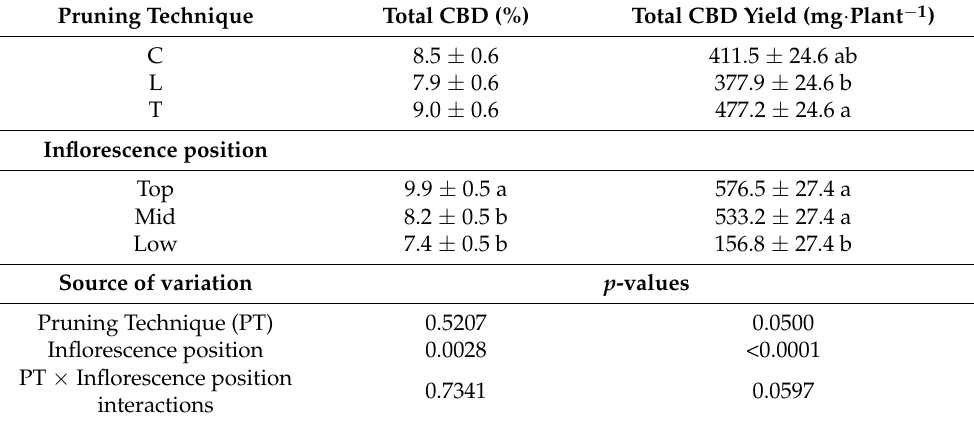
Table 5. Least square means ( ± standard error) of total CBD concentration (%) and total CBD yield (mg · plant − 1 ) for each pruning technique (PT) and inflorescence position at the third harvest time (9 weeks of flowering). Means for each PT and for each inflorescence position with at least one identical letter are not significantly different from each other according to Fisher ´ s LSD test with α = 0.05. Means for PT for total CBD (%) are not significantly different from each other for PT according to global F-test. Pruning techniques (C—control; L—lollipop; T—topping). Note that p -values correspond to F-test within an ANOVA. Pruning